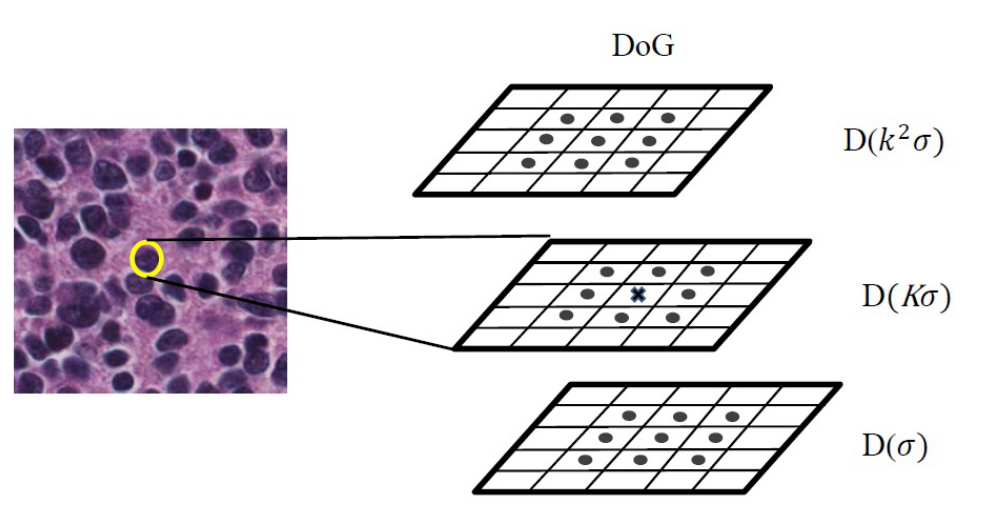
Figure 6. The scheme of keypoint detecting. DoG, Difference of